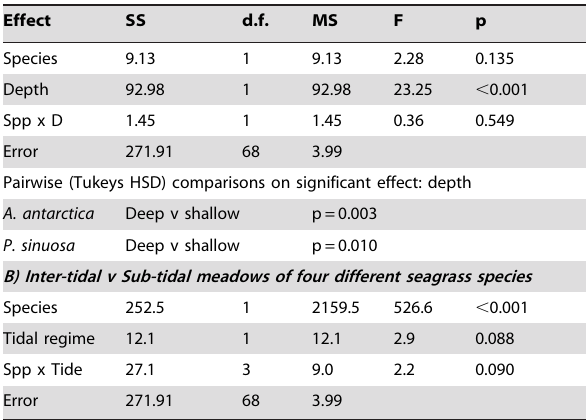
significant effects of Species and Habitat (Deep v Shallow (A) or Tidal v Inter-tidal (B)) on the C org storage in the top 25 cm of seagrass sediments.